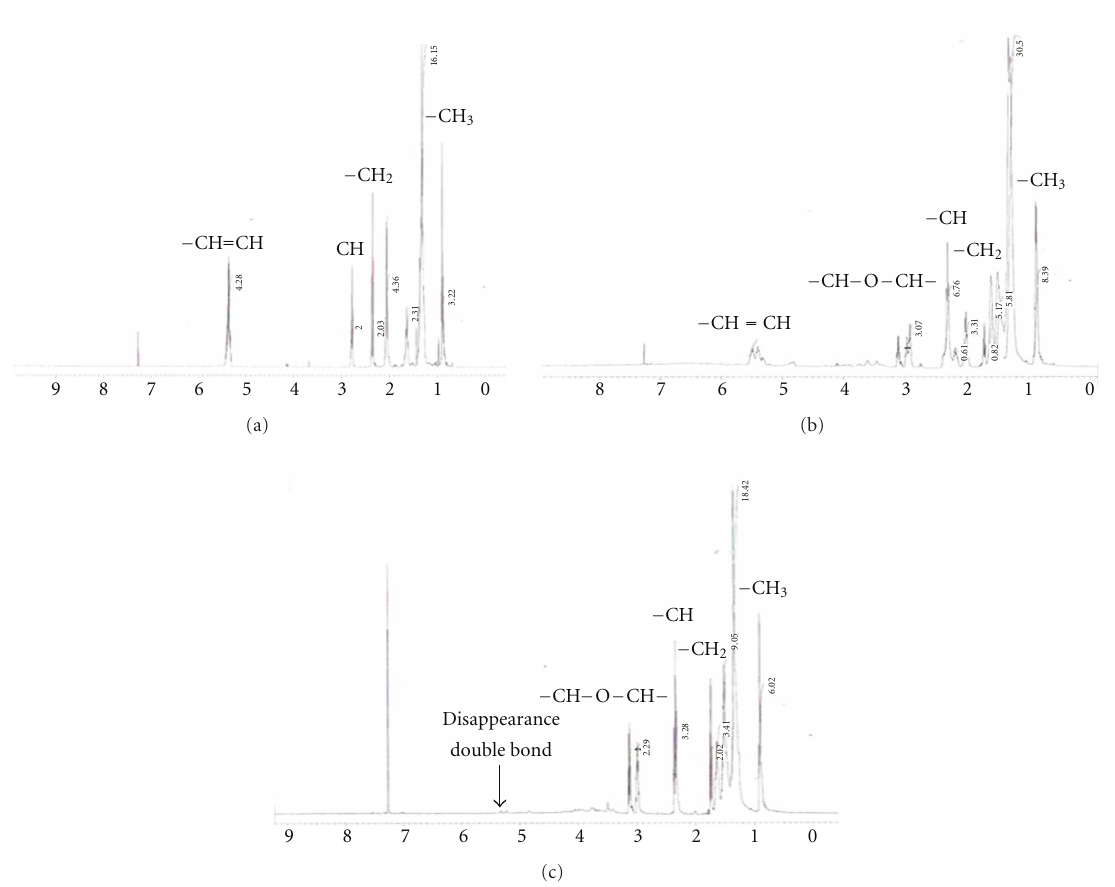
Figure 8: 1 H NMR spectrum of LA (a), MEOA (b) and di-epoxide LA